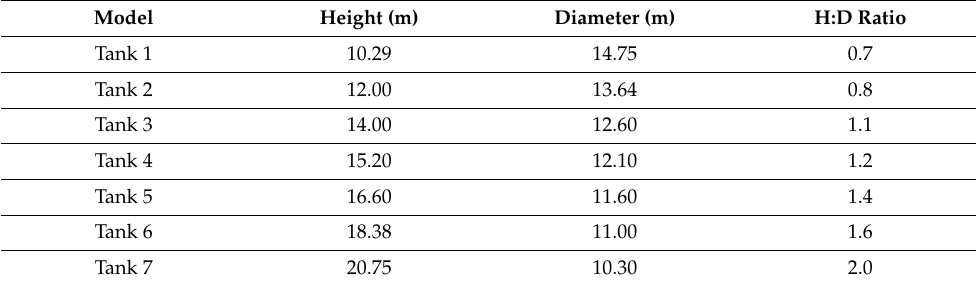
Table 2. Dimensions of the modeled tanks at various H:D